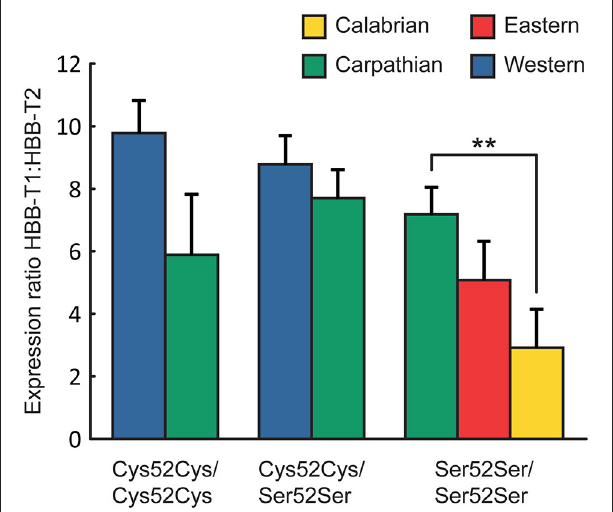
FIGURE 3 | Expression ratio HBB-T1:HBB-T2 (LS Mean ± SE) of different two-locus genotypes (HBB-T1/HBB-T2) across populations (defined by mtDNA clade affinity; see Table 1 ). ** P < 0.01 (ANOVA with Tukey-Kramer